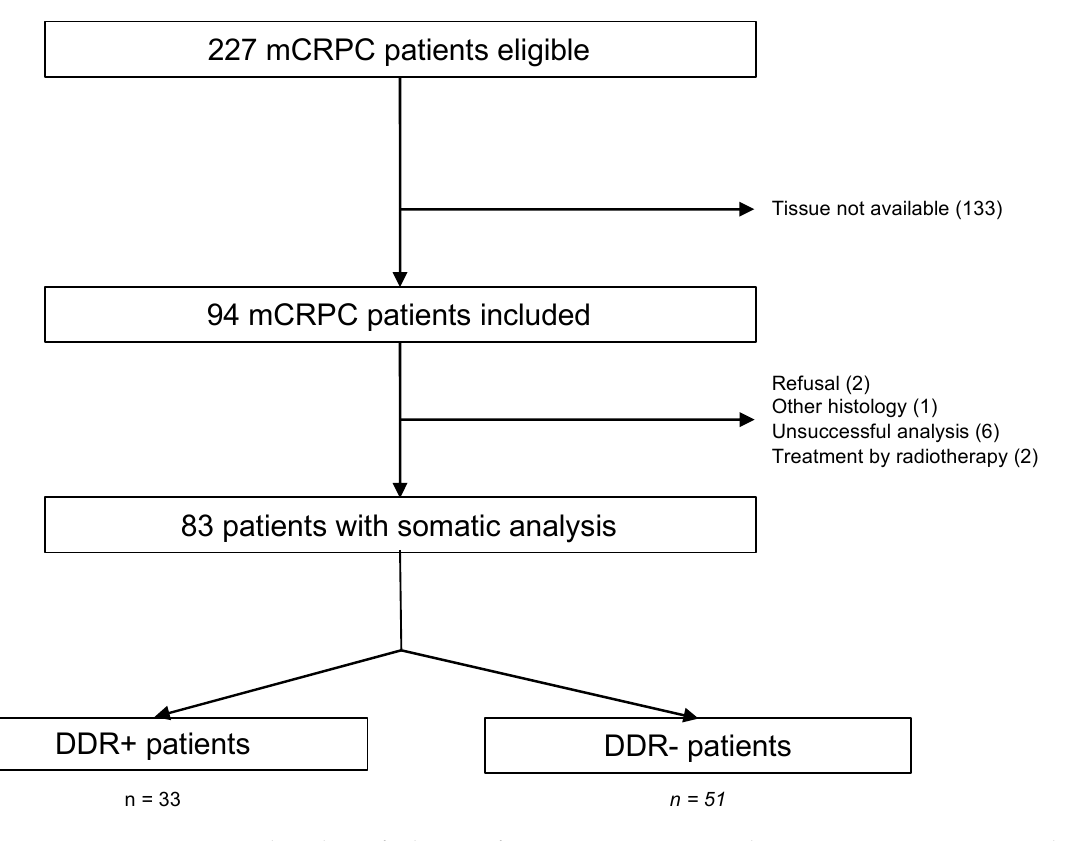
Figure 1. Flow chart of selection of patients. DDR+: mutated patients; DDR − : non-mutated patients; mCRPC: metastatic castration-resistant prostate cancer; n : number of patients.